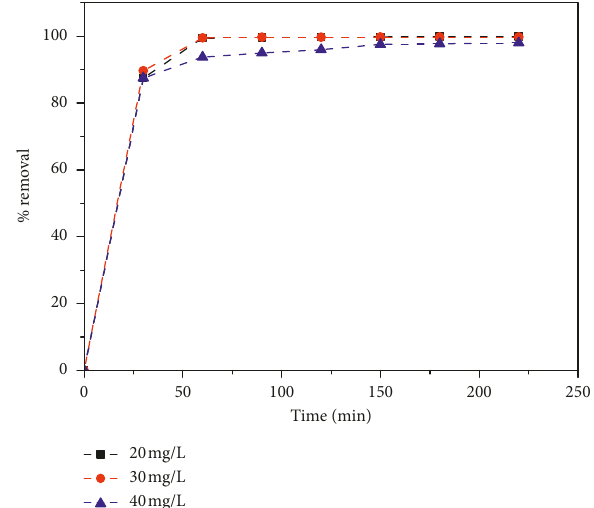
Figure 6: Effect of contact time on adsorption of MB onto